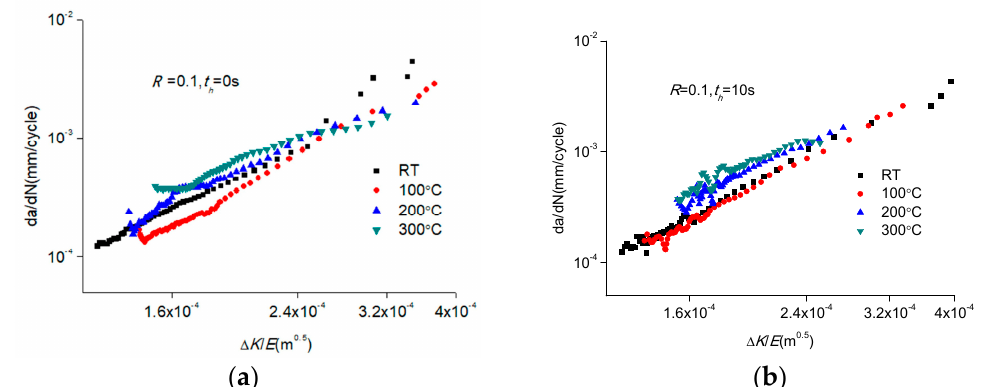
ratio: ( a ) pure fatigue; ( b ) dwell fatigue. Figure 7. Diagrams of da/dN– ∆ K / E FCG curves of CP-Ti at different temperatures under low load Figure 7. Diagrams of da/dN– Δ K / E FCG curves of CP-Ti at different temperatures under low load